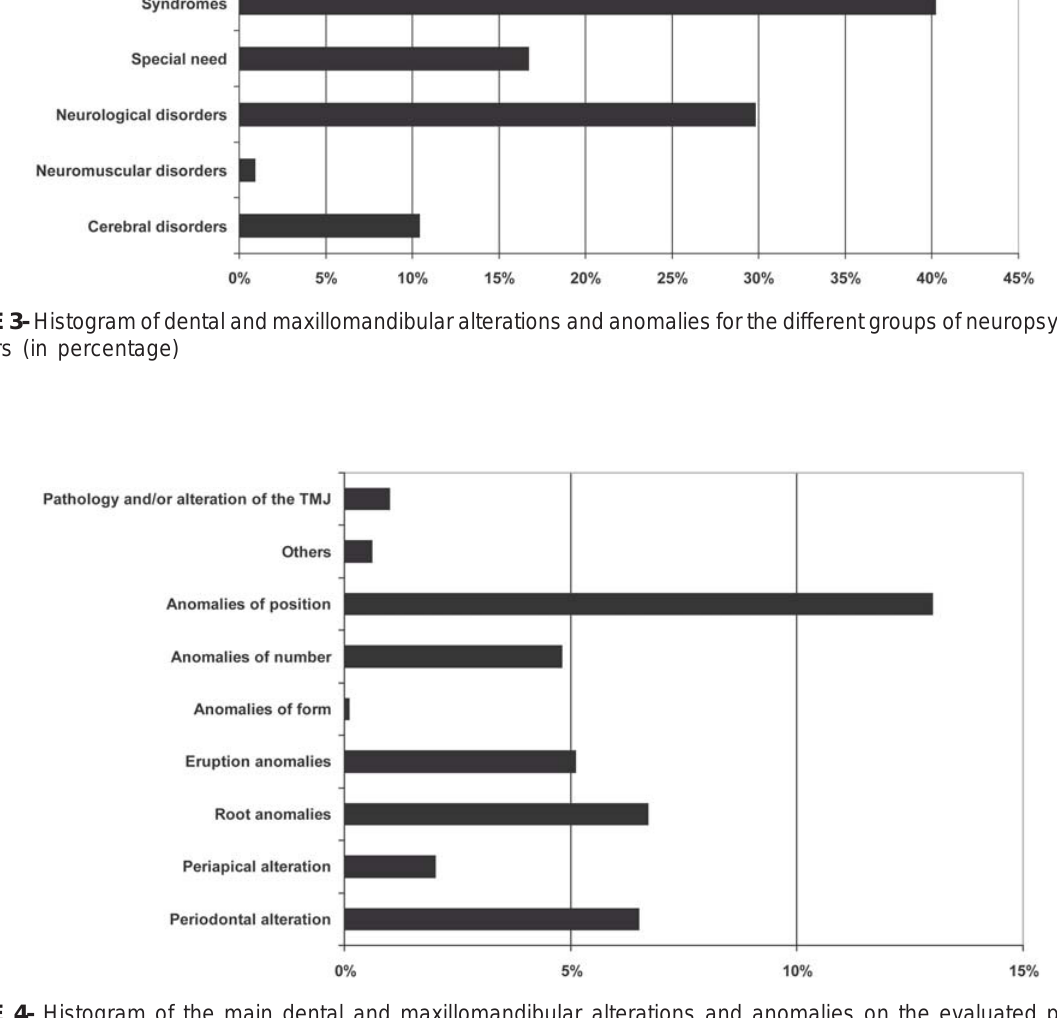
FIGURE 4- Histogram of the main dental and maxillomandibular alterations and anomalies on the evaluated panoramic